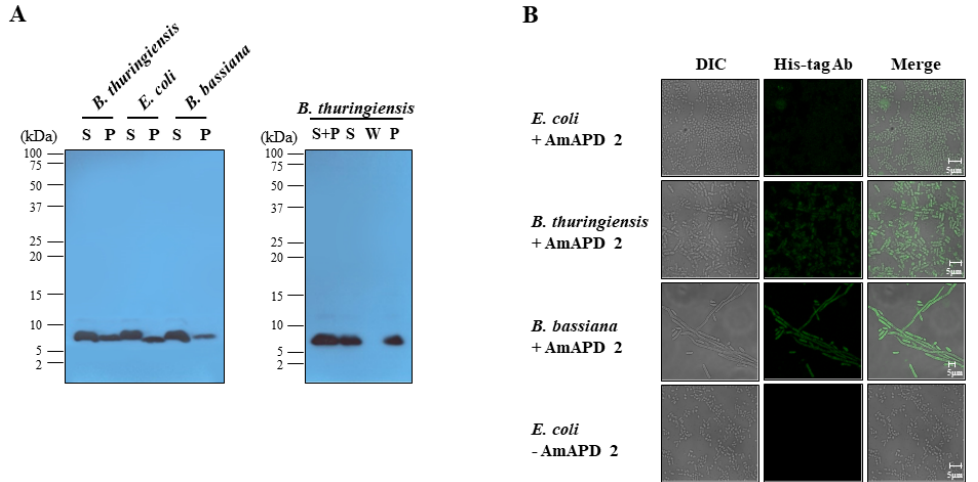
Figure 4. The binding ability of recombinant Apis mellifera apidermin 2 (AmAPD 2) to microbial cell walls. ( A ) Western blot analysis of the binding of recombinant AmAPD 2 to microbial cell walls. Live E. coli , B. thuringiensis , or B. bassiana cells were treated with the recombinant AmAPD 2 for 10 min. The pellet (P) and supernatant (S) represent AmAPD 2 bound to the microbial pellet and free AmAPD 2 in the supernatant, respectively (Left panel). Live B. thuringiensis cells were treated with the recombinant AmAPD 2 that had been preincubated at 50 °C for 1 h (Right panel). As a control in the heat-pretreatment experiment, the wash sample (W) used was the supernatant in the second washing step of the pellet. Western blotting was performed using an anti-His-tag antibody. ( B ) Immunofluorescence staining of E. coli , B. thuringiensis , or B. bassiana cells showing the binding of recombinant AmAPD 2 (green) to the microorganisms’ cell walls. Staining was performed using an anti-His-tag antibody. For a negative control, E. coli cells pre-incubated without recombinant AmAPD 2 were used ( E. coli -AmAPD 2). Merged confocal images are shown in which scale bars = 5 μ m.